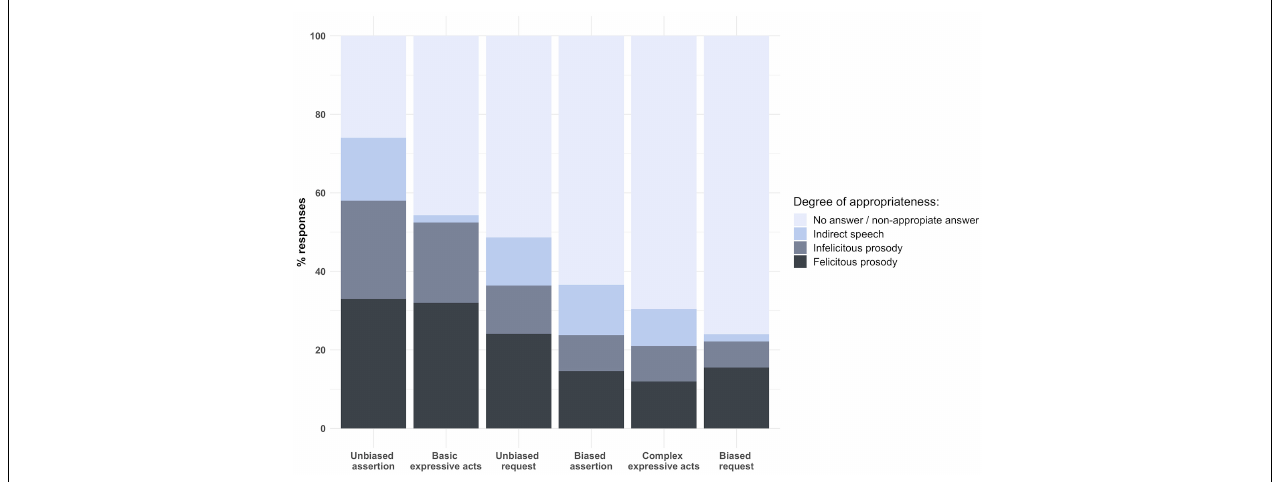
FIGURE 3 | Percentage of prosodically felicitous responses by children, broken down by speech act category and degree of